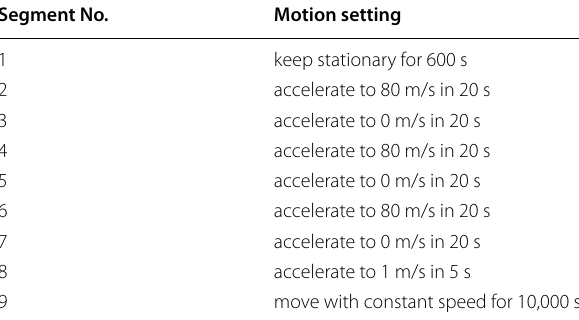
Table 1 Description of the dynamic motion of the host vehicle Segment